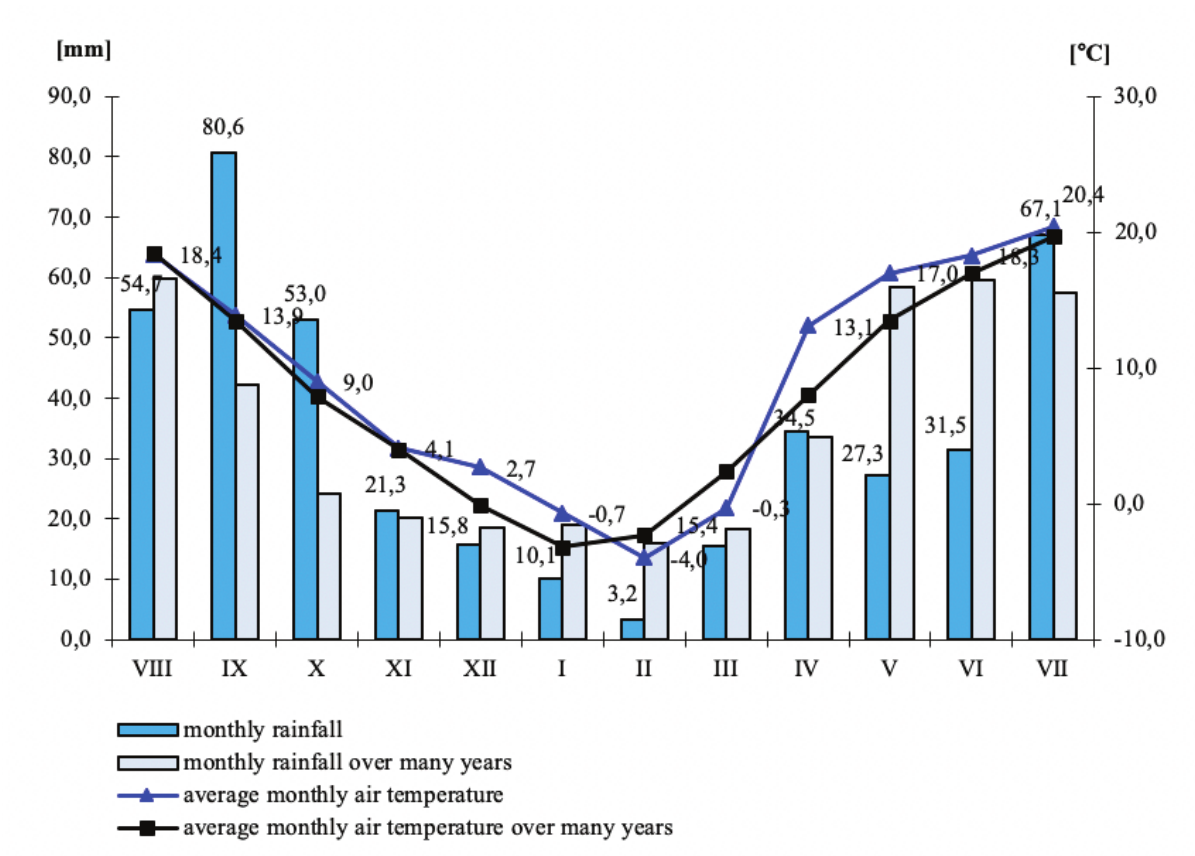
Table 1: Characteristics of weather conditions in the years 2016- 2019 (Zawady Meteorological Station.